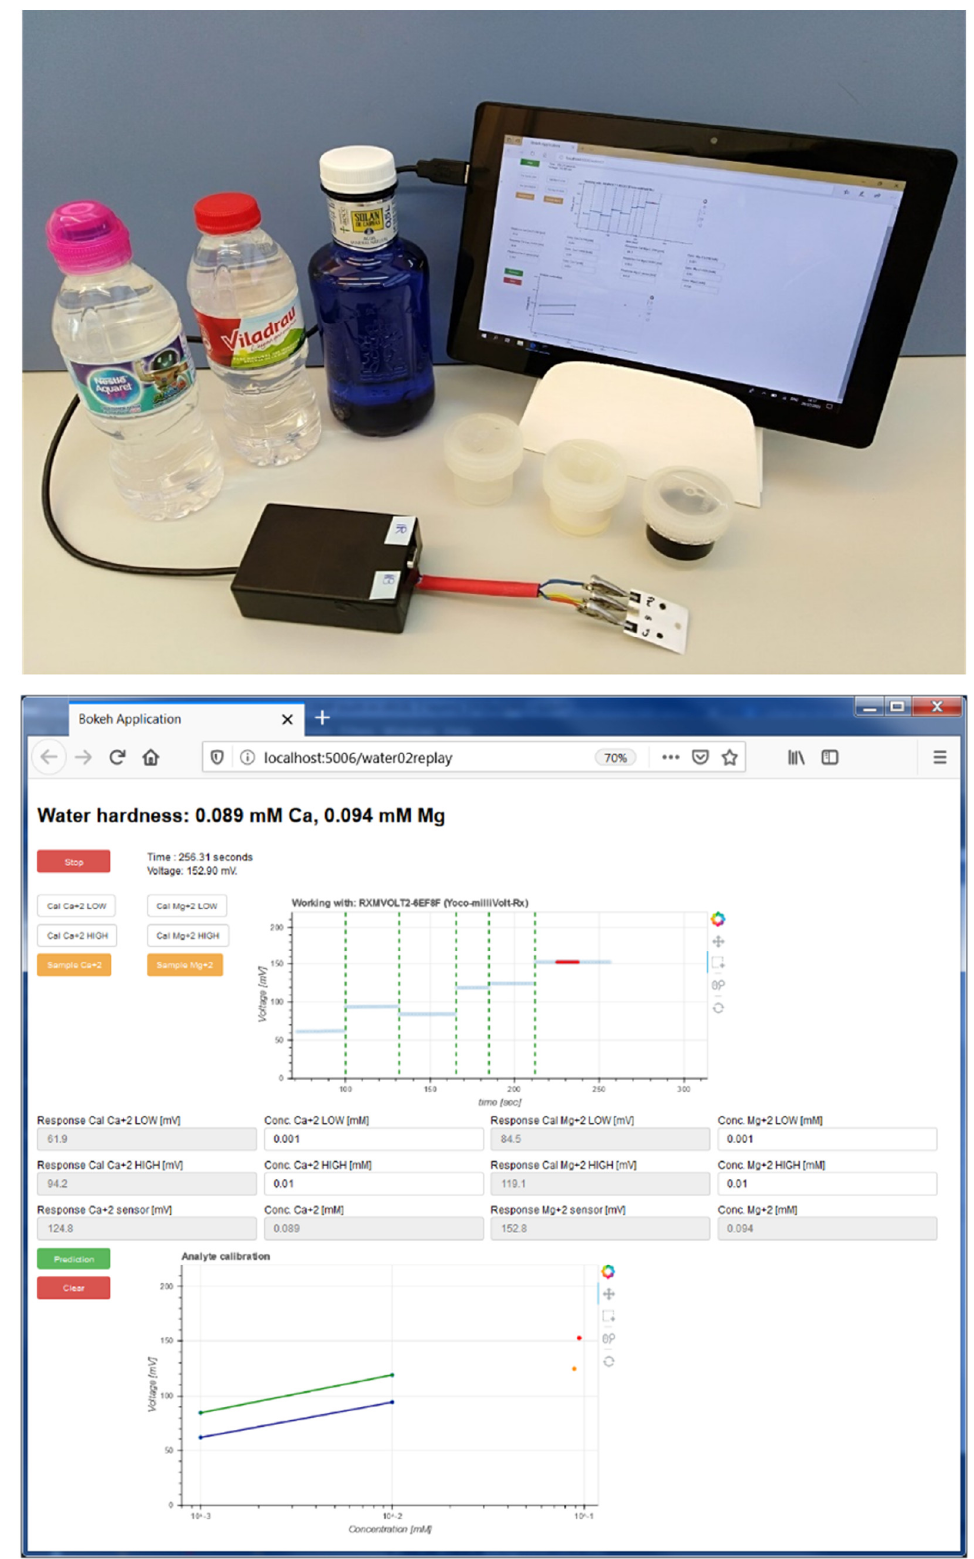
Figure 5. Set-up of decentralized measurement with the paper-based potentiometric cell, portable potentiometer connected to a tablet with software for data analysis (left); screenshot of the time trace, calibration curve and prediction of the hardness degree (right).